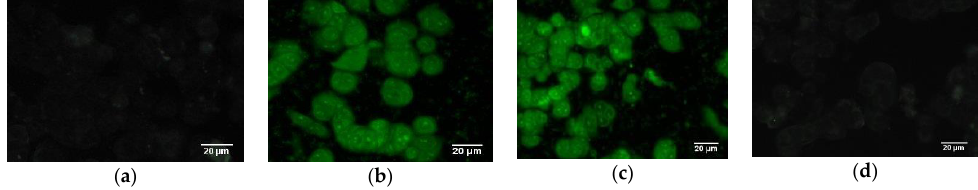
Figure 5. NTERA-2 cells after 1 h of incubation with ( a ) TbPO 4 ·H 2 O@silica-NH 2 ; ( b ) TMC (TbPO 4 ·H 2 O@silica-NH2-mAb^CD133-mAb^PD-L1); ( c ) CD133-FITC; and ( d ) negative control; observed using an Olympus Scan^R 100X fluorescent microscope system.